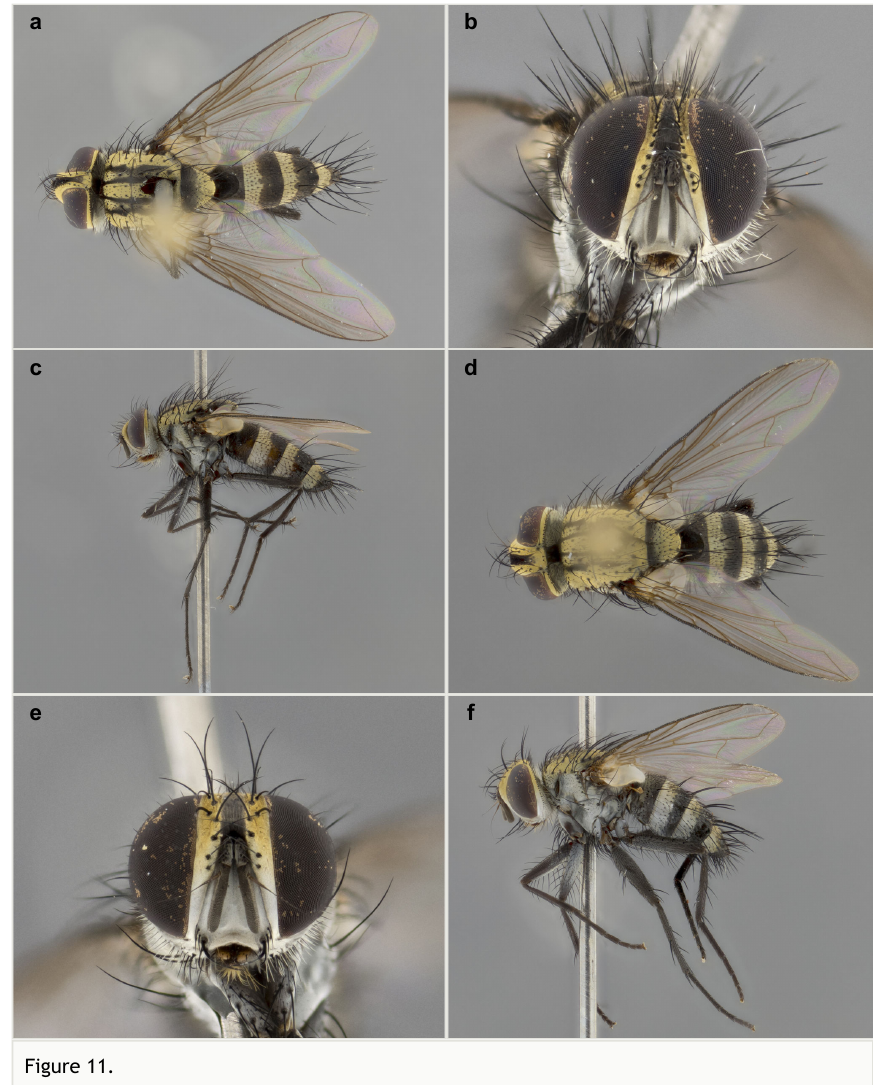
General morphology of Calolydella destituta sp. n. ; a–c : male holotype, voucher